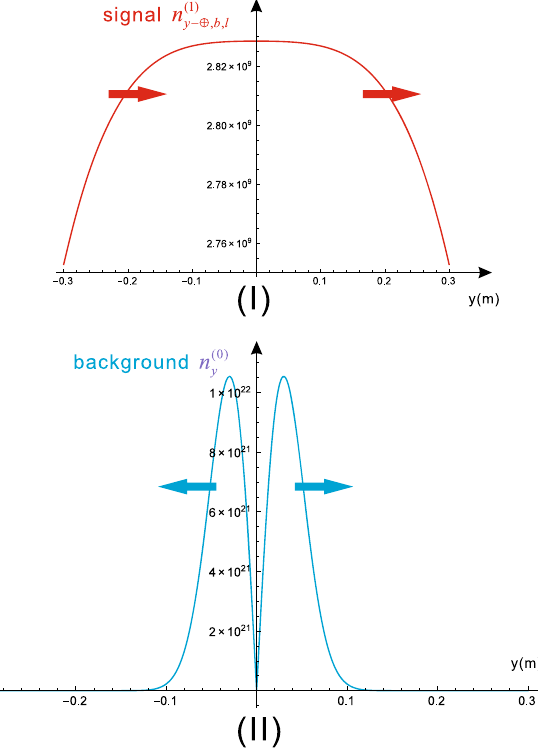
Fig. 8 Comparison of diagrams of the signal photon flux n ( 1 ) and background photon flux n gates along the positive direction of the y -axis in the suitable resonance region, and the background noise photon flux n the opposite directions of the y -axis of y > 0 and y <